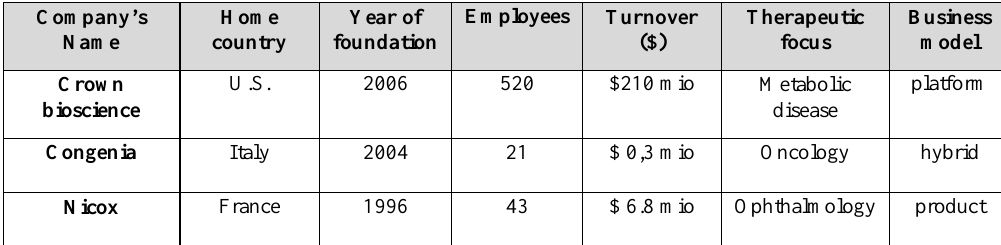
Table 1: Descriptives of the Three Biotech